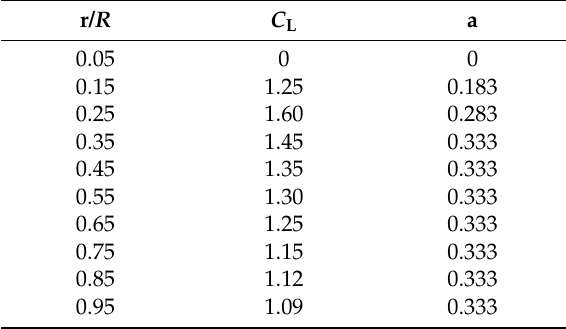
Table A1. Lift coefficient and axial induction factor